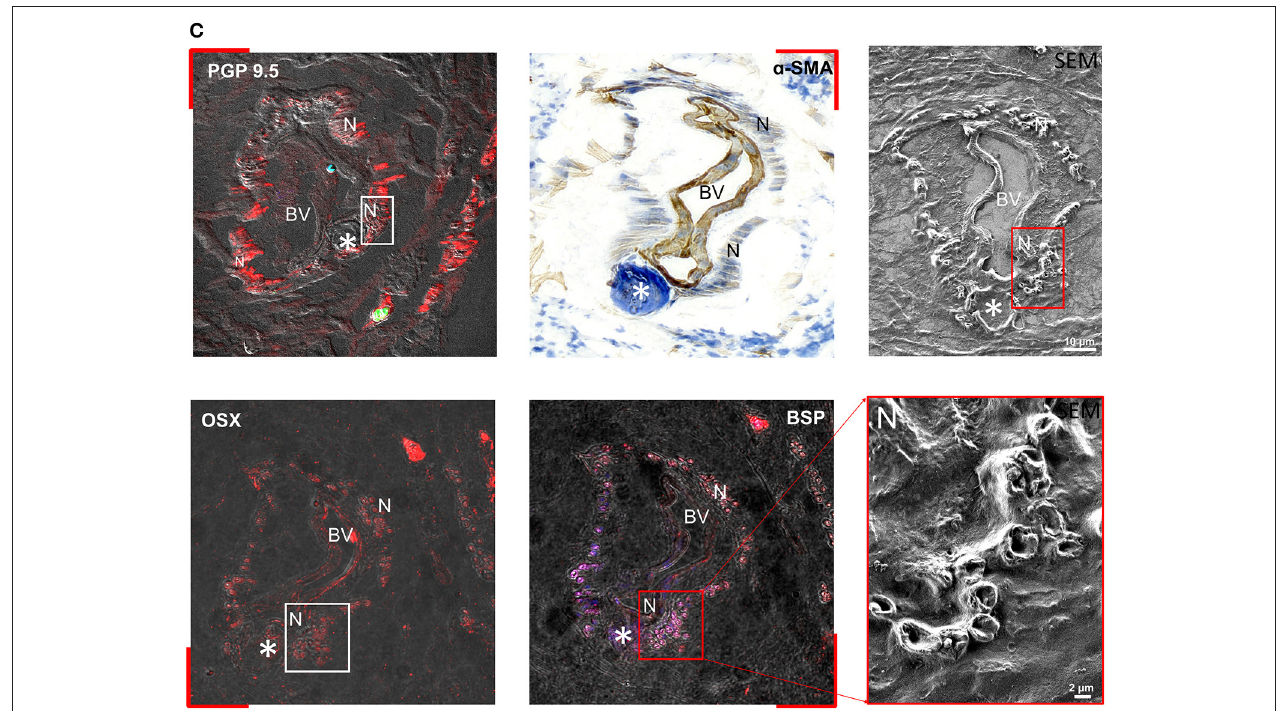
FIGURE 3 | Acidic molecules are contained within the minerals and the matrix of mineralizing pulp. (A) Digital volume illustrates the location of mineralized pulp (inside the box outlined in orange). (a) Minerals of varying densities are shown in transverse X-ray tomogram (outlined white rectangle) and corresponding histologic and immunohistologic sections with a visible dentin-pulp interface (red arrowhead) are shown (b–h). Light micrographs (LM) illustrate odontoblast cells relative to fibroblasts and other cells in the mineralizing matrix in hematoxylin and eosin (H&E, b; Red box contains dentin-pulp interface with corresponding cells), collagenous regions in Masson’s trichrome (c), and mineralizing regions in von Kossa (d) stained sections. Osteocalcin (OCN, e), osteopontin (OPN, f), protein gene product 9.5 (PGP9.5, g), and α -smooth muscle actin ( α -SMA, h) are localized in the blood vessels and nerves of the mineralizing pulp. (B) Histologic stains for mineral using von Kossa (a), and immunolocalization of PGP9.5 (b), OPN (c), and OCN (d) antigens are visible in the mineralized objects within the organic extracellular matrix of nerves and blood vessels. The corresponding extracellular matrix of the immunolocalized proteins are shown in electron micrographs to the right. (C) Nerve bundles (PGP 9.5) and blood vessels ( α -SMA) in association with osteogenic molecules osterix and bone sialoprotein (OSX, BSP) within pulp were immunolocalized. BV, blood vessel; N, nerve; M, mineralizing tissue; LV, lymphatic vessels; red arrowhead points to the dentin-pulp interface (DPI). Immunolocalization of the same proteins, but in unmineralized pulp are shown in Supplementary Figure S1